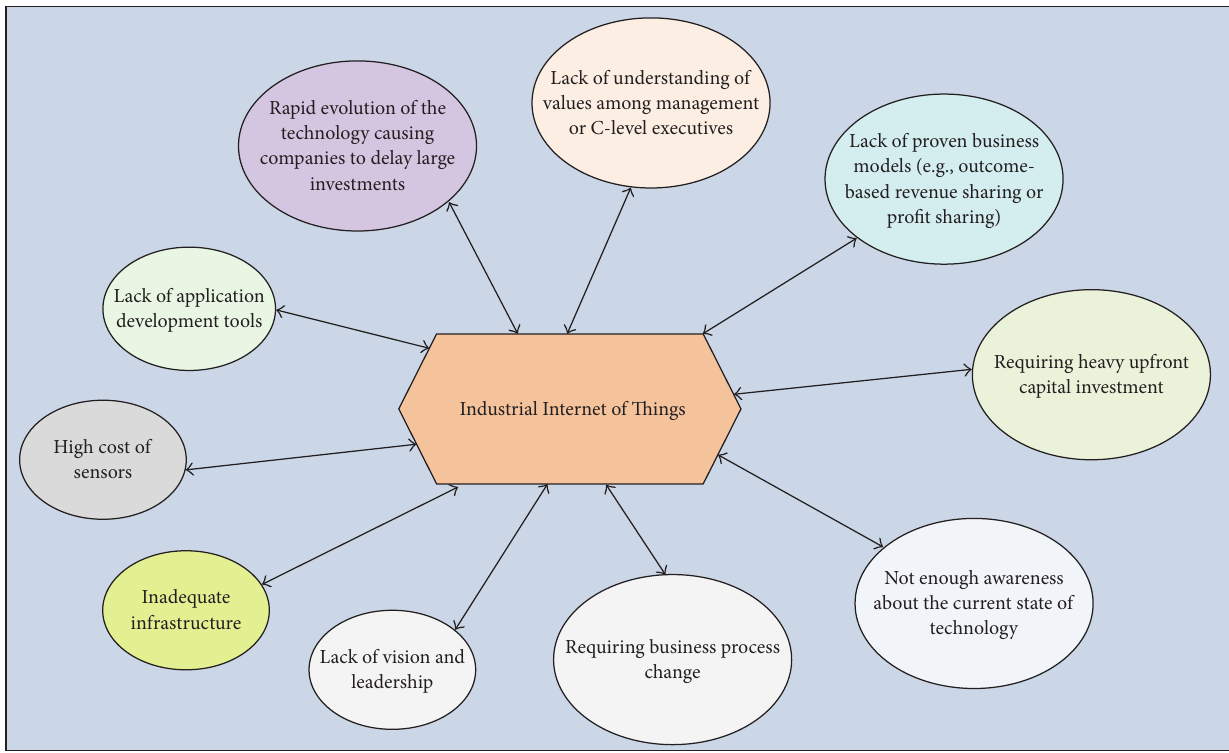
Figure 4: Risk factors of Industrial